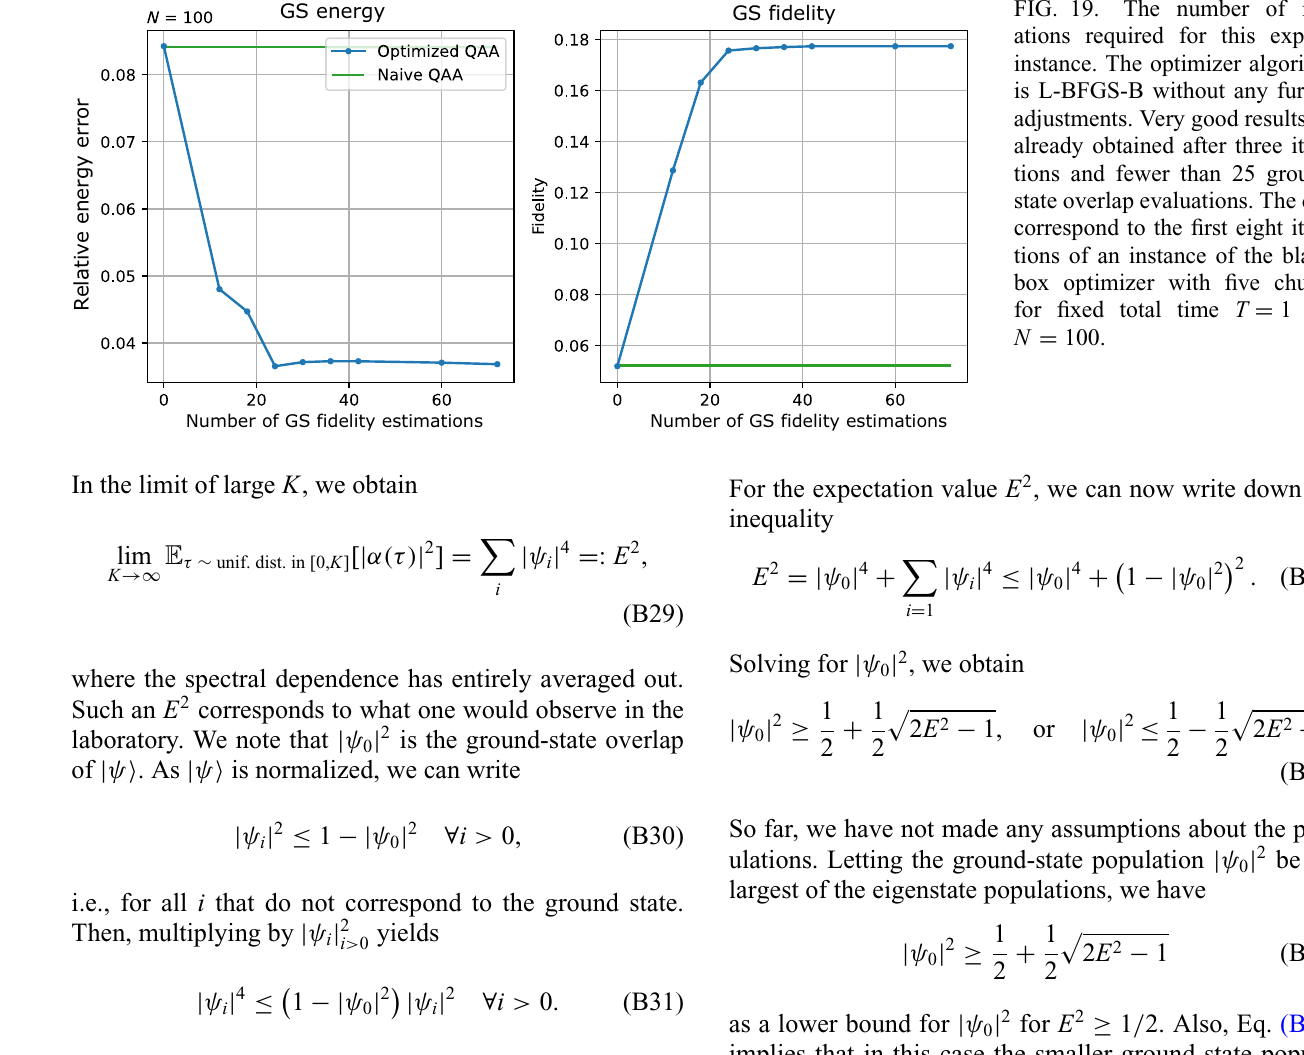
FIG. 20. The number of mea- surements for this explicit instance obtained using the Chernoff- Hoeffding inequality and the assumptions mentioned in the main text. For a total of a few thousand measurements, the end result of the adiabatic evolution is already improved